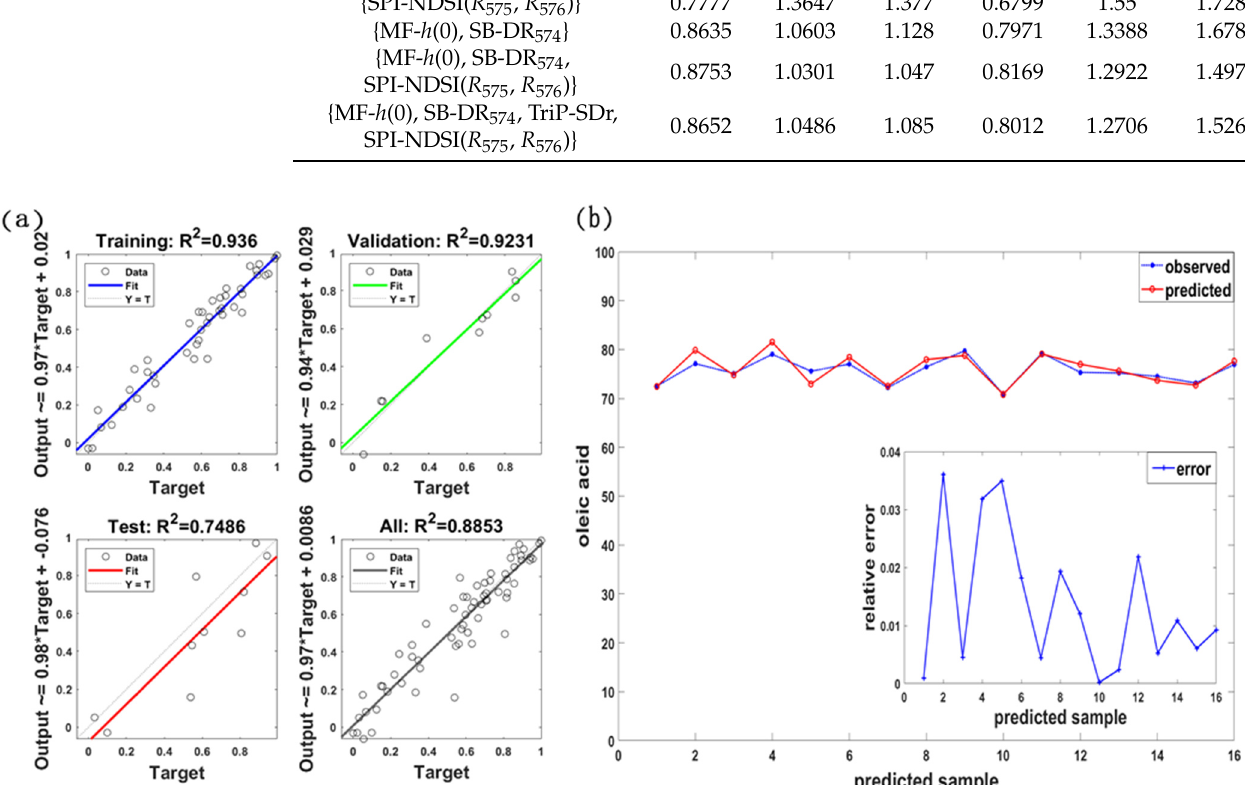
Figure 4. Model results obtained from the ternary combination {MF- h (0), SB-DR 574 , SPI-NDSI( R 575 , R 576 )}. ( a ) is for the 64 training samples. ( b ) is for the 16 testing samples.